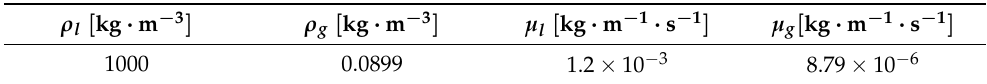
Table 1. Physical parameters